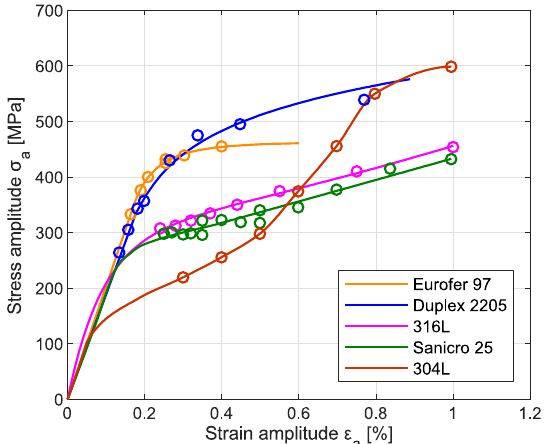
Figure 19. Comparison of experimentally measured and numerically modeled cyclic stress–strain curves of selected materials.